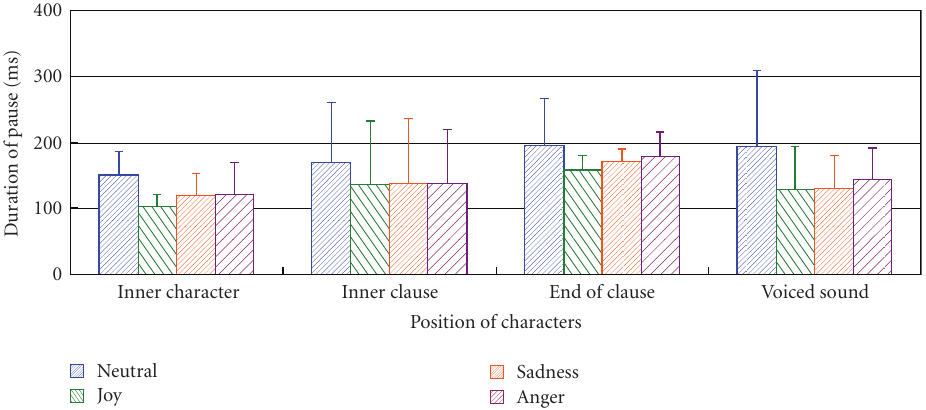
Figure 17: Mean of duration of pause as a function of emotions and position of characters for one-handed Finger Braille (error bars represent standard